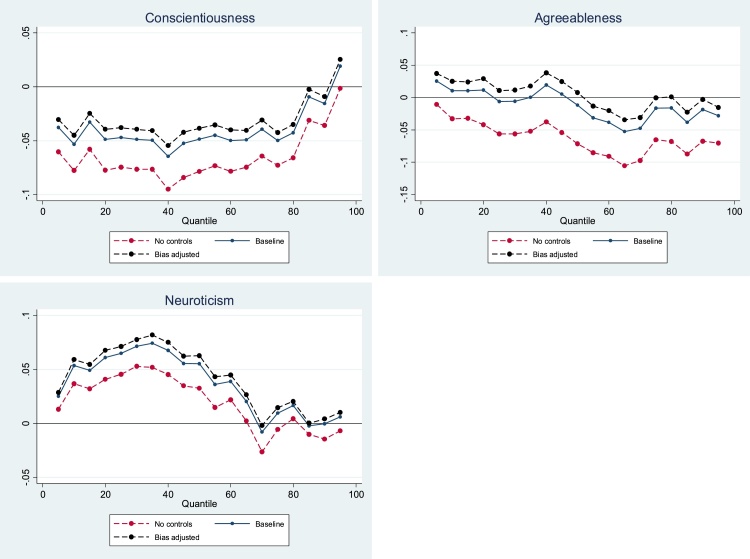
Adolescent non-cognitive skills – triglyceride-HDL ratio omitted variable bias adjusted relationship.